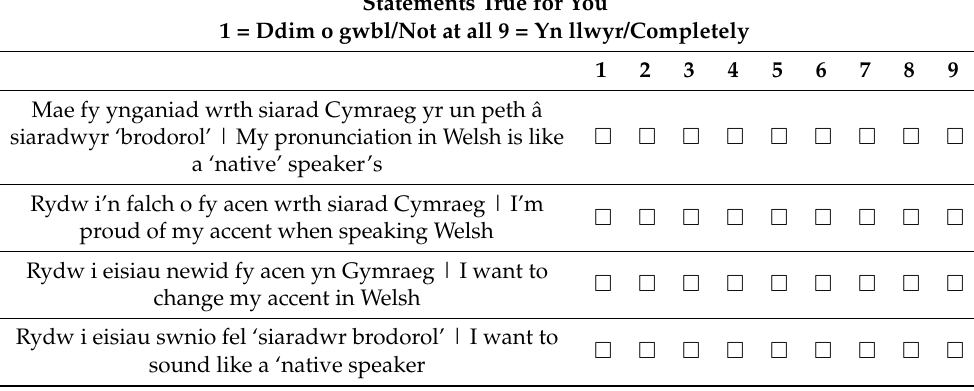
Table A2. Individual aspects of pronunciation items in the